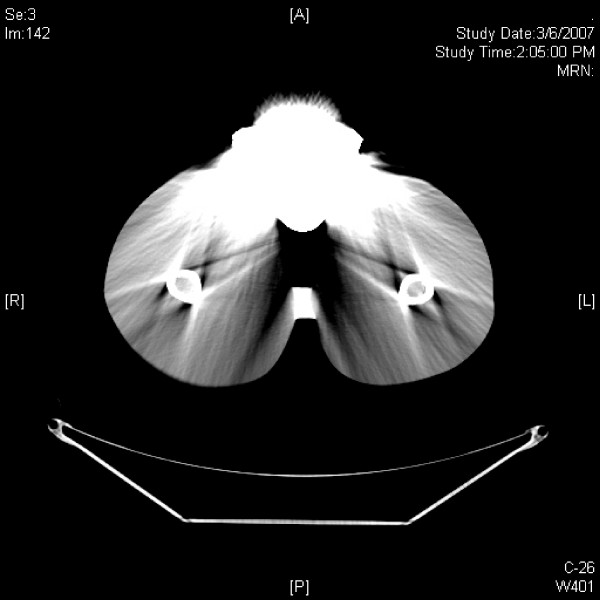
Pelvic CT image of Humanoid phantom. Pelvic CT image with gonad shield in place and directly situated in the beam. Note the severe streaking artifacts and general image degradation.